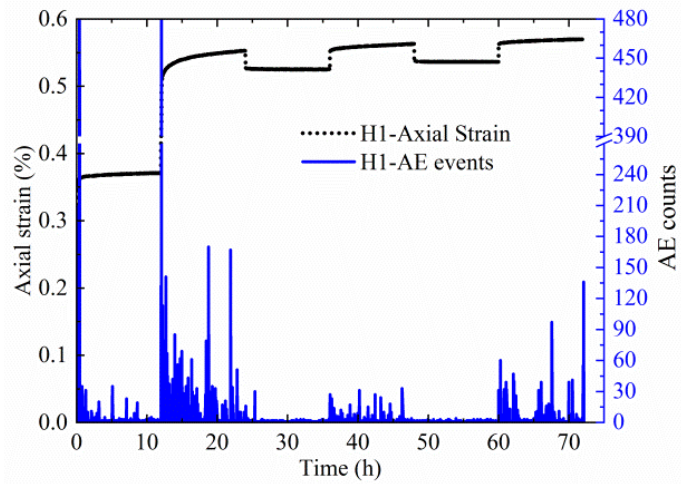
Figure 10. Axial strain and AE events versus time; the number of AE events is shown “AE counts”.